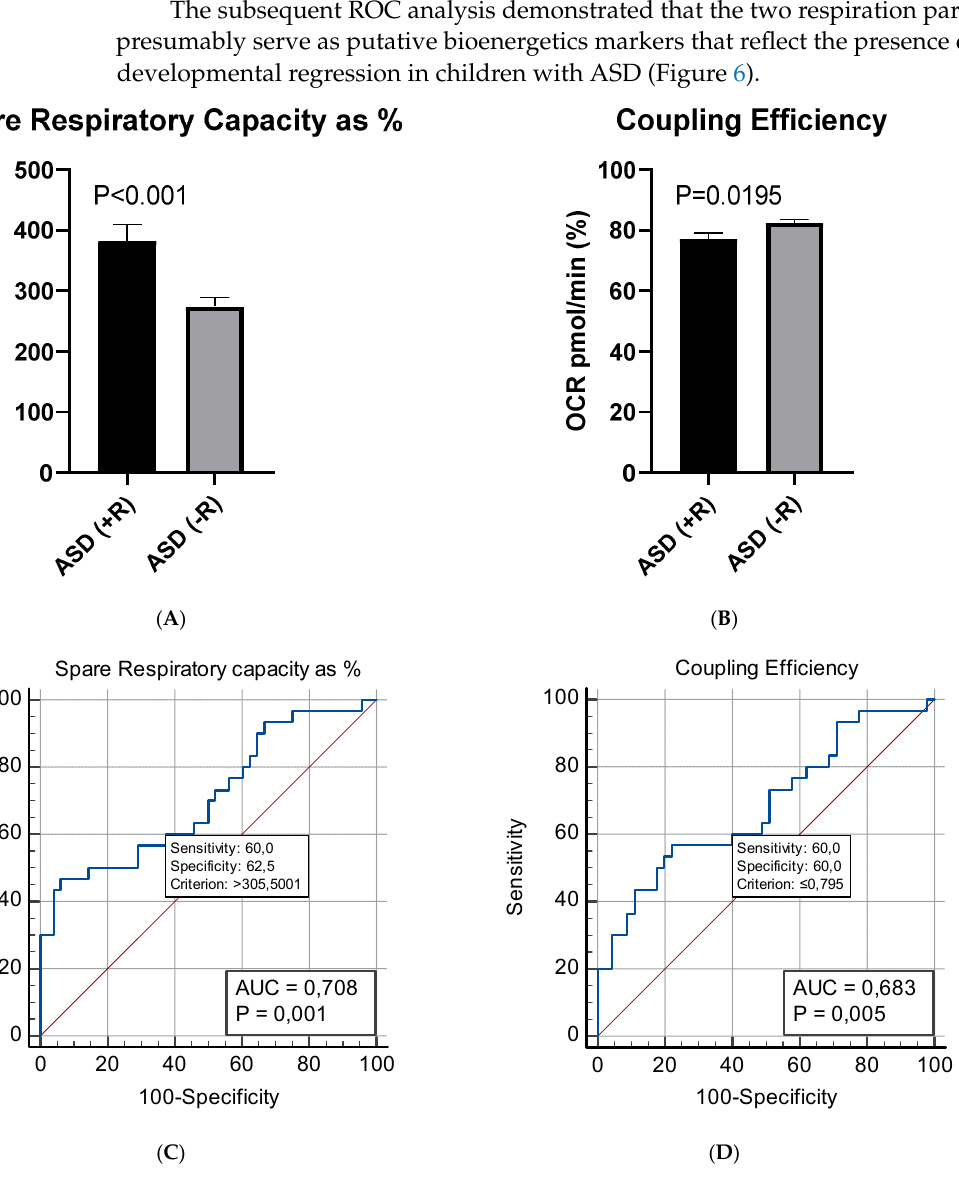
Figure 6. Mean differences in: ( A ) Spare Respiratory Capacity as %; ( B ) Coupling Efficiency between children with (+R) ( n = 15) or without (−R) ( n = 25) developmental regression; ( C , D ) ROC analysis of mitochondrial respiration parameters in children with and without developmental regression.